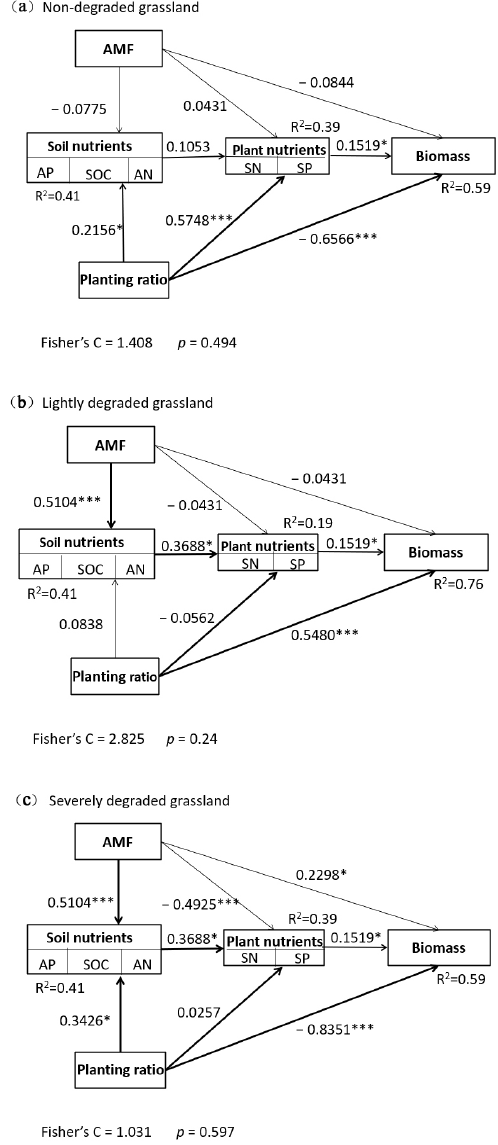
Figure 13. Structural equation models showing the effects of AMF addition and planting ratio on plant shoot biomass through soil nutrients and plant shoot nitrogen and phosphorus contents. ( a ) Non-degraded grassland. ( b ) Lightly degraded grassland. ( c ) Severely degraded grassland. Square boxes denote variables included in the models. Soil nutrient variables include soil NH 4 + -N, NO 3 − -N, available P, and soil organic carbon. Soil nutrients are synthetic variables derived from the first axis of principal component analyses. The thickness of arrows is proportional to the standardized path coefficient. *** p < 0.001, * p < 0.05, p < 0.1 indicate the significance level of each effect. R 2 values represent the proportion of variance explained for each endogenous variable.